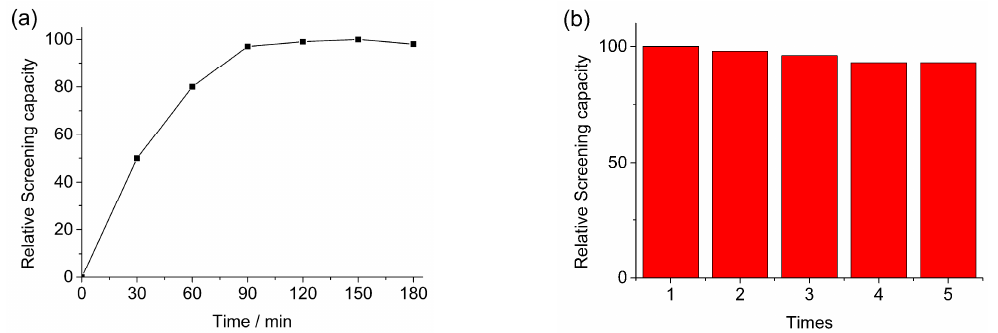
Figure 5. ( a ) Effect of screening time on the screening capacity. ( b ) Reusability of Fe 3 O 4 @SiO 2 -XO nanoparticles.